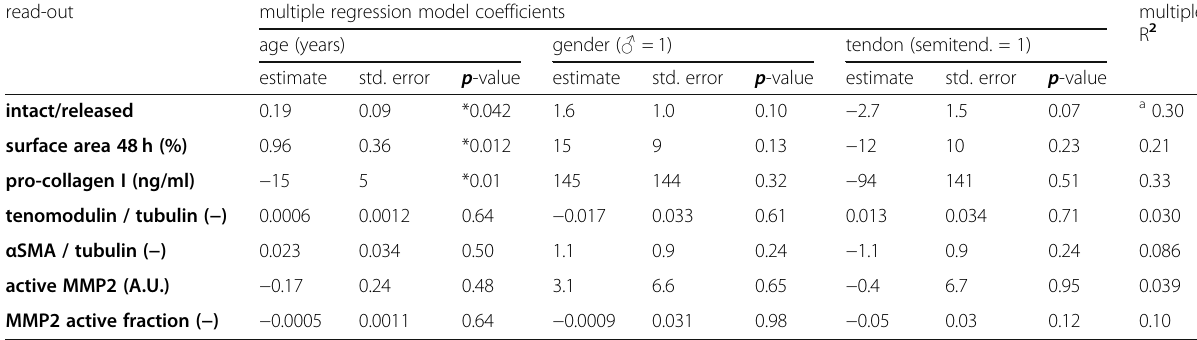
Table 2 Results multiple regression models. a Pseudo-R 2 , since multiple R 2 is not defined for logistic regression read-out